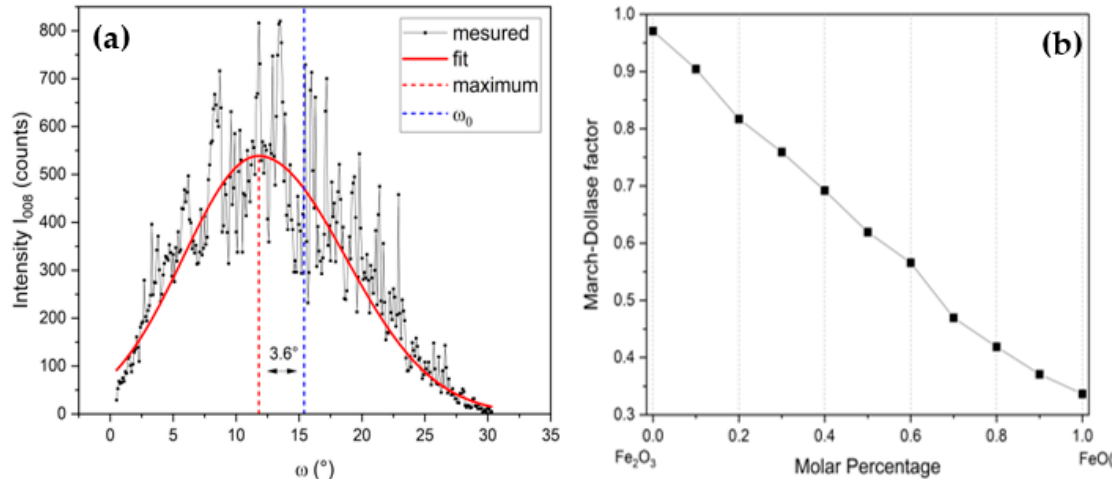
Figure 7. ( a ) Rocking curve for the intensity of the (008) Bragg diffraction pic. ( b ) Evolution of the March–Dollase factor as a function of mole percentage of goethite.